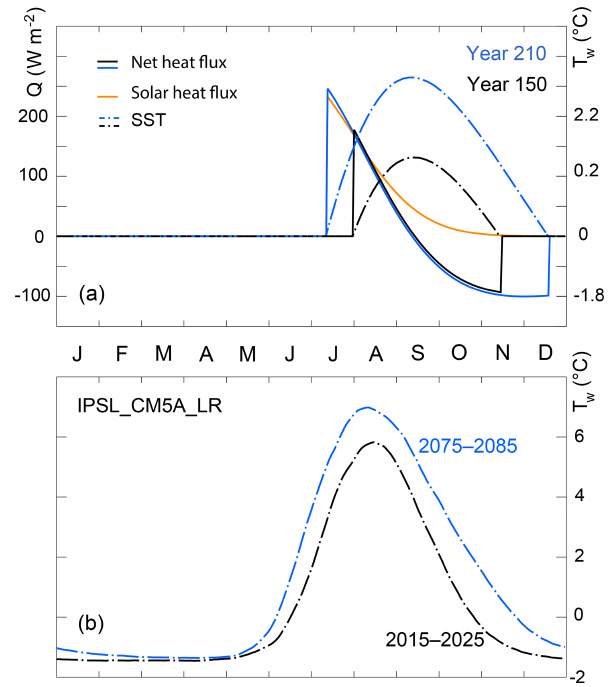
Figure 7. (a) Energetics of ice retreat and advance in the simple model: net atmospheric (solid) and solar (yellow) heat fluxes to the ocean; SST (dash), depicted for years 150 and 210. (b) Annual evo- lution of the simulated sea surface temperature, averaged over the seasonal ice zone, for 2 decades of reference (2015–2025, 2075– 2085) as simulated by the IPSL_CM5A_LR model and showing the same temporal asymmetry as in the simple